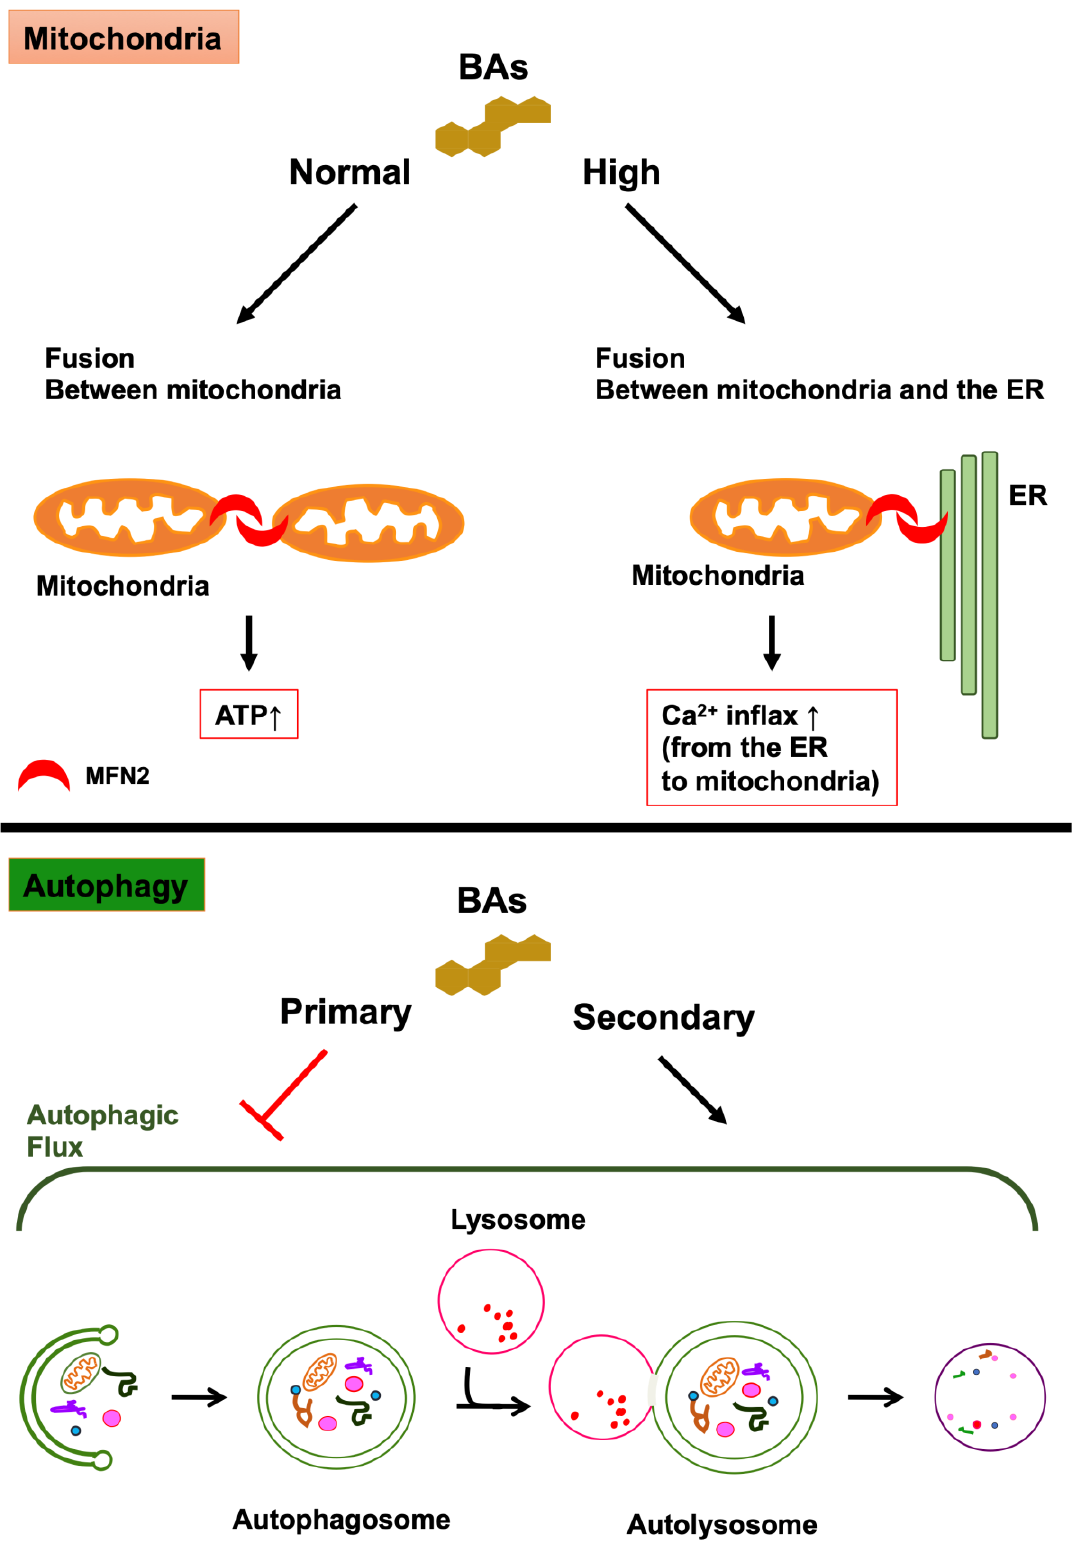
Figure 2. The effects of bile acids (BAs) on mitochondria and autophagy. The effects of BAs on mitochondria: DCA, CDCA, and their taurine conjugates activate MFN2 by binding directly to MFN2, promoting mitochondria-to-mitochondria fusion and mitochondria-to-ER fusion. These BAs, at normal concentration, promote the fusion between mitochondria, leading to the generation of ATP. By contrast, these BAs, at high concentration, promote the fusion between the mitochondria and the ER, leading to Ca2 + influx from the ER to the mitochondria. The effects of BAs on autophagy: